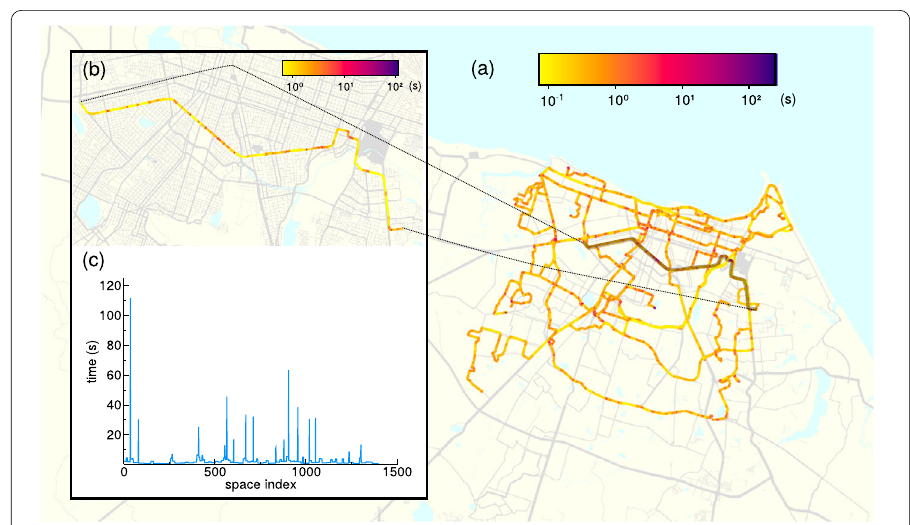
Figure 2 Map of time in logarithmic color scale. ( a ) Several morning bus trips are shown in Fortaleza. The trips were divided into constant spaces of (cid:2) s ∗ = 10 m and the colors plotted on the map are the values of log 10 (cid:2) t ∗ , with their values indicated in the scale. ( b ) One trip from the several in ( a ) is selected and highlighted on the map ( a ). The start and end locations of this trip are also illustrated. The route of this trip is performed by the 75 bus route with (cid:2) s ∗ = 10 m and the colors shown in ( b ) correspond to the values of (cid:2) t ∗ in a logarithmic scale. ( c ) Time series of (cid:2) t ∗ of the interpolated path of the trip em ( b ). Each value of the